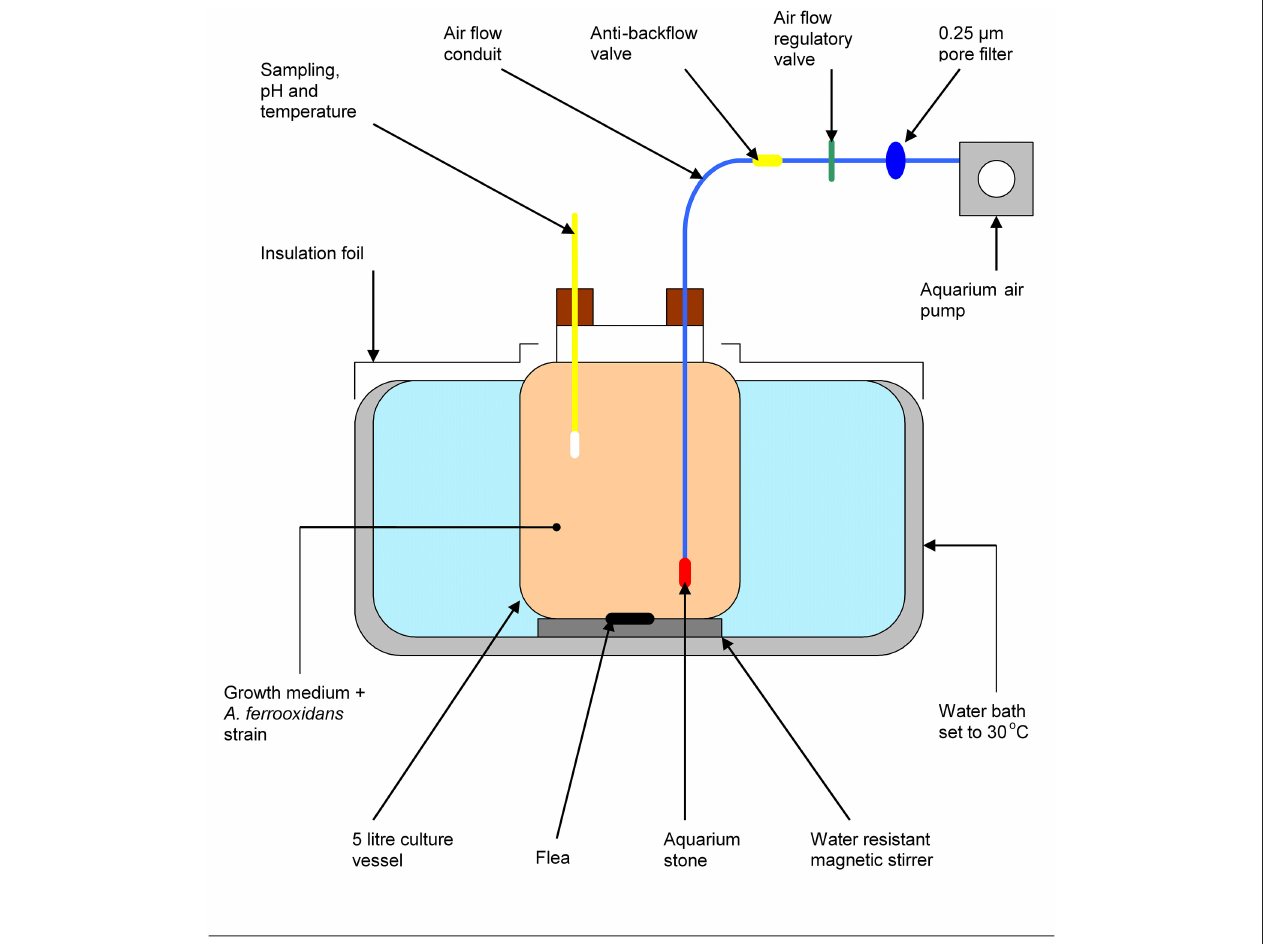
FIGURE 1 | Design sketch of the bioreactor showing its components. The total volume of the vessel was 5 L of a mine water solution containing 100mg U(VI) L − 1 . Temperature and pH probes were inserted to monitor the reaction during time. Oxygen was constantly supplied via a aeration pump. The temperature was kept to a constant value of 30 ◦ C using a water